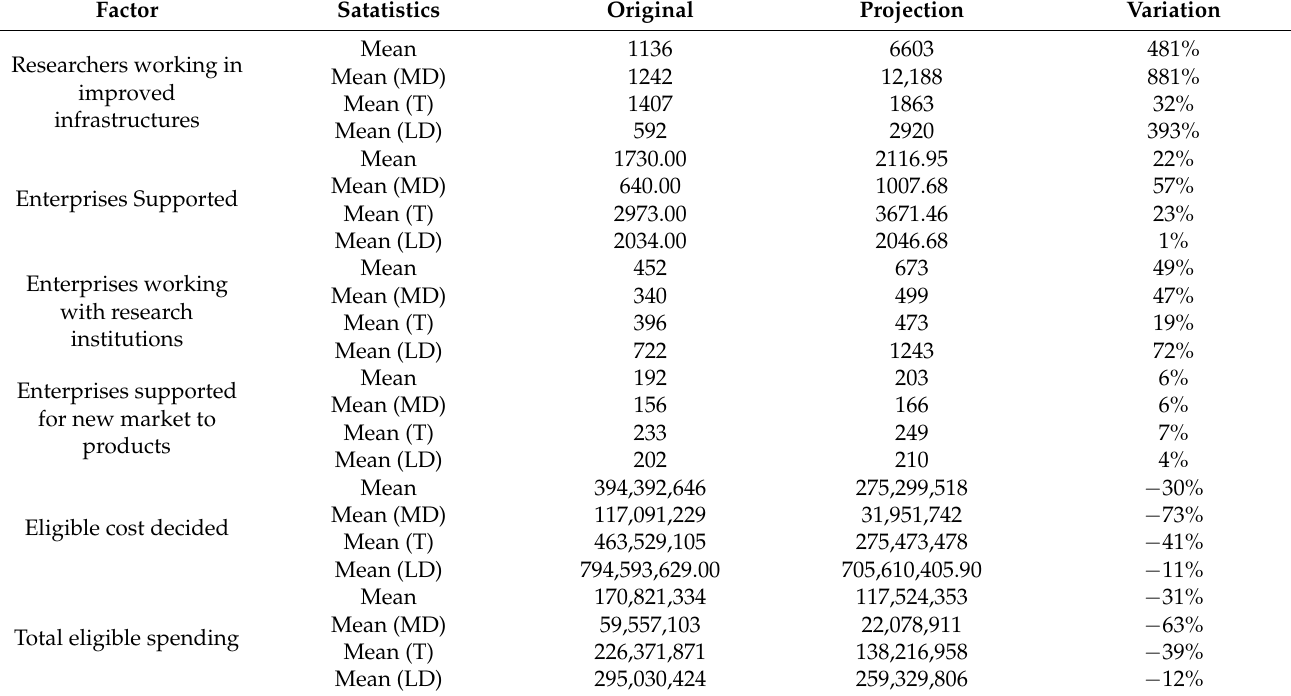
Table 9. Improvement potential for the OPs—Overall network cluster